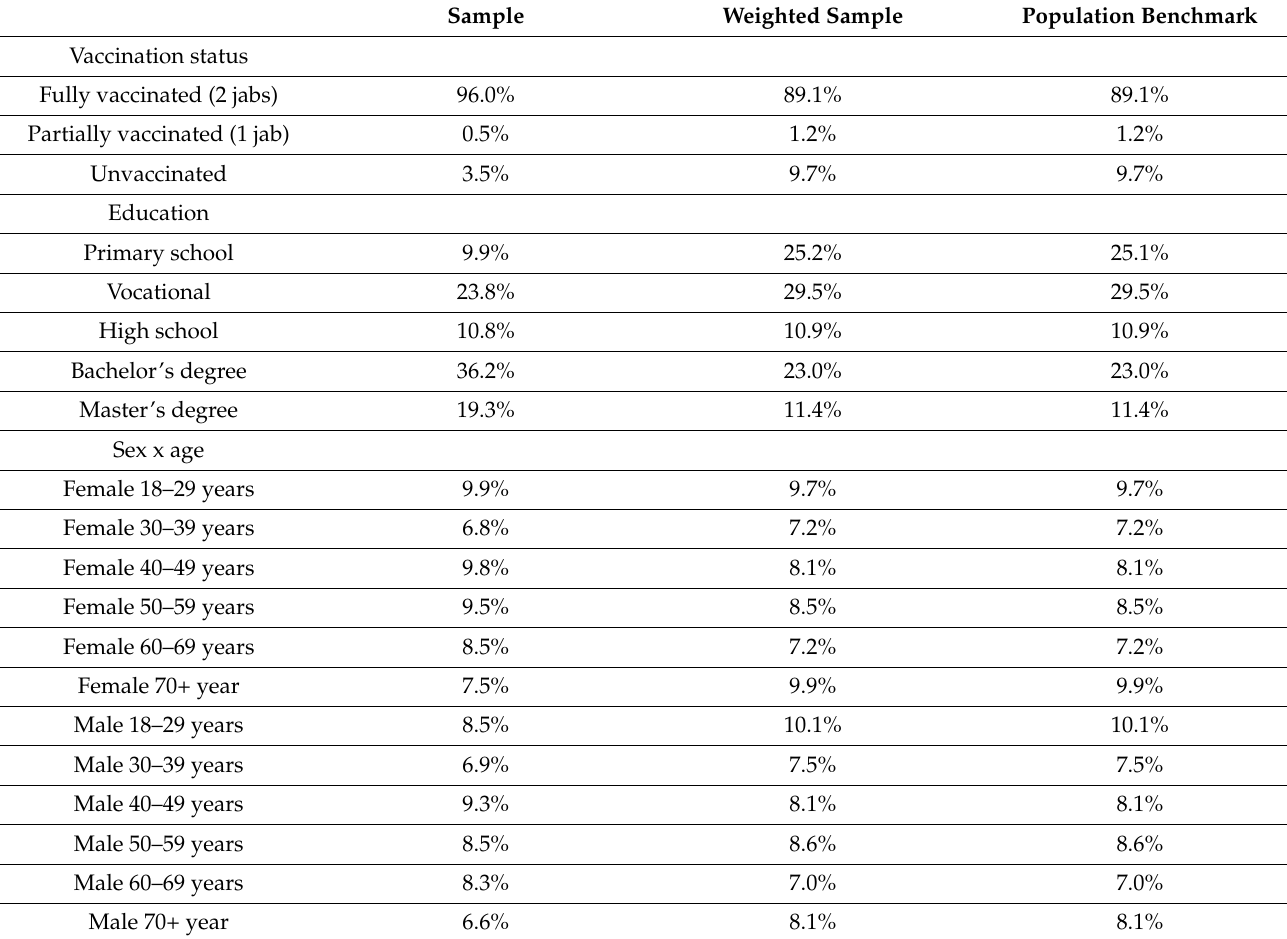
Table 1. Population margins versus sample and weighted sample